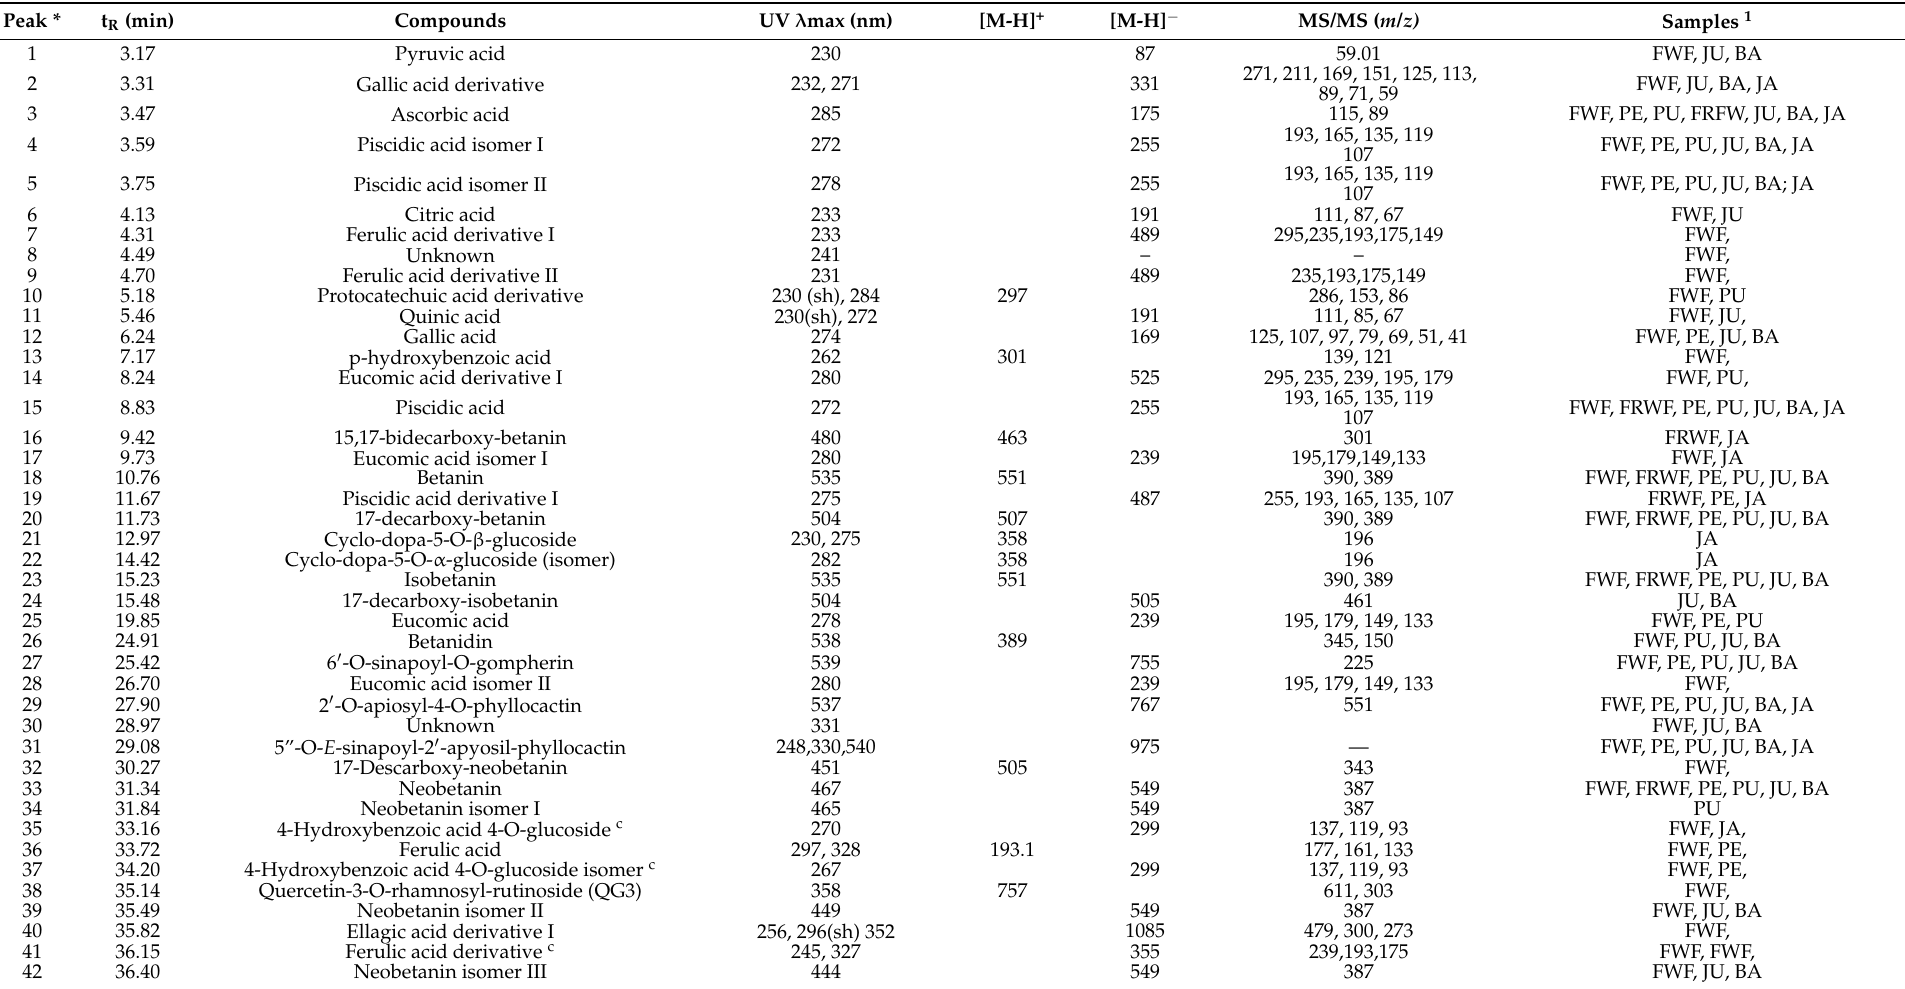
Table 1. HPLC retention times (Rt), U V/V is spectra, and MS/MS spectral data of betalains, phenolic compounds, and organic acids in Opuntia stricta, var. Dillenii fruit tissues (peel, pulp, and whole fruit), jam production products (intermediate juice and jam), and by-product (bagasse). Peak